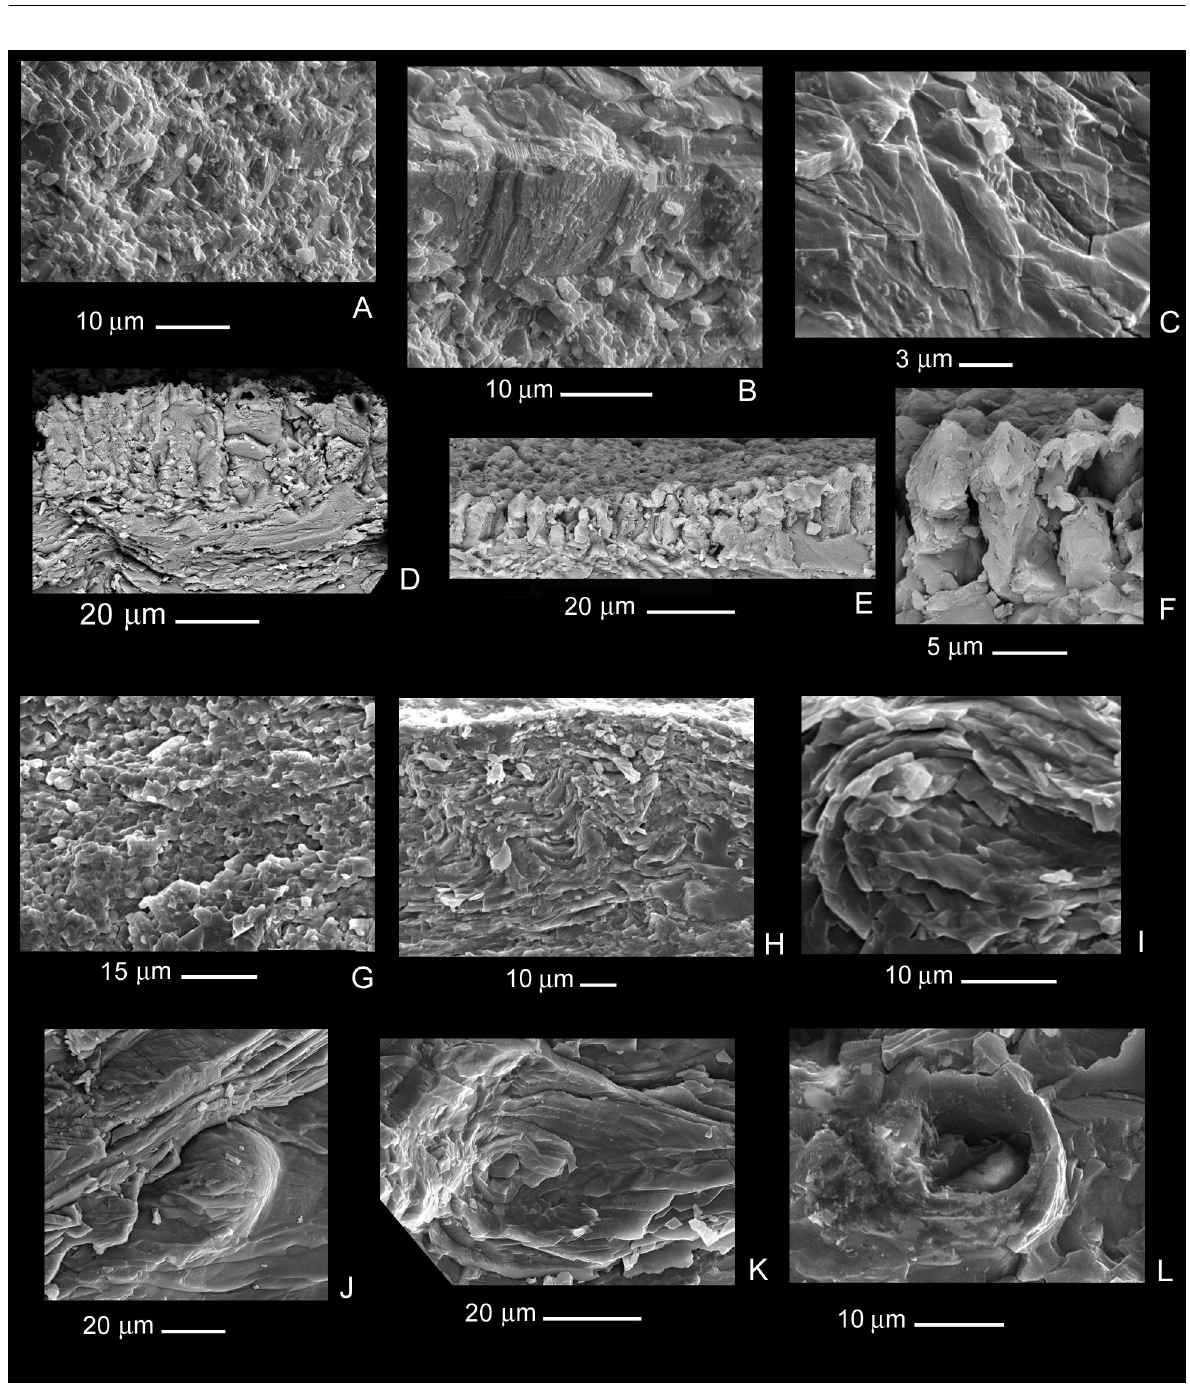
Fig. 2. A – C , three variously altered sublayers of the secondary layer in the umbonal region of the ventral valve: inner sublayer of cubical granules (A), sublayer of solid diagenetic calcite (B), upper sublayer of cross-bladed laminae (C), PIN 4921/661. D , possible tertiary layer of densely spaced thick vertical columns in ventral valve PIN 4921/781. E , F , altered tertiary layer of separate vertical crystals, ventral valve PIN 4921/664. G , longitudinal section of the inner sublayer of the secondary layer with small isoform, irregularly shaped elements. H , three densely spaced pseudopunctae on longitudinal section. I , longitudinal section through a pseudopuncta lacking taleola. J , upper view of a pseudopuncta in the secondary laminae. K , inner view of a pseudopuncta composed of deflected laminae. L , possible thin taleola, dorsal valve PIN